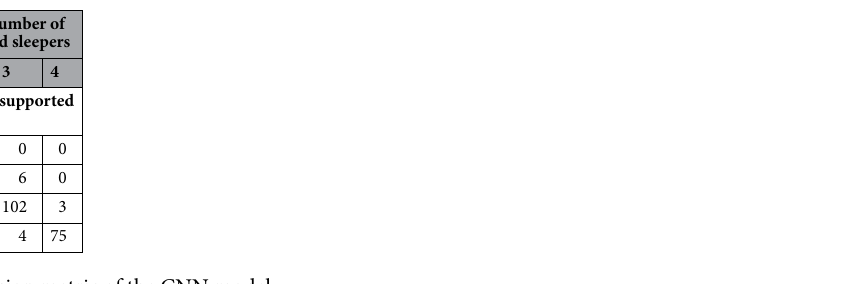
Table 7. Confusion matric of the CNN